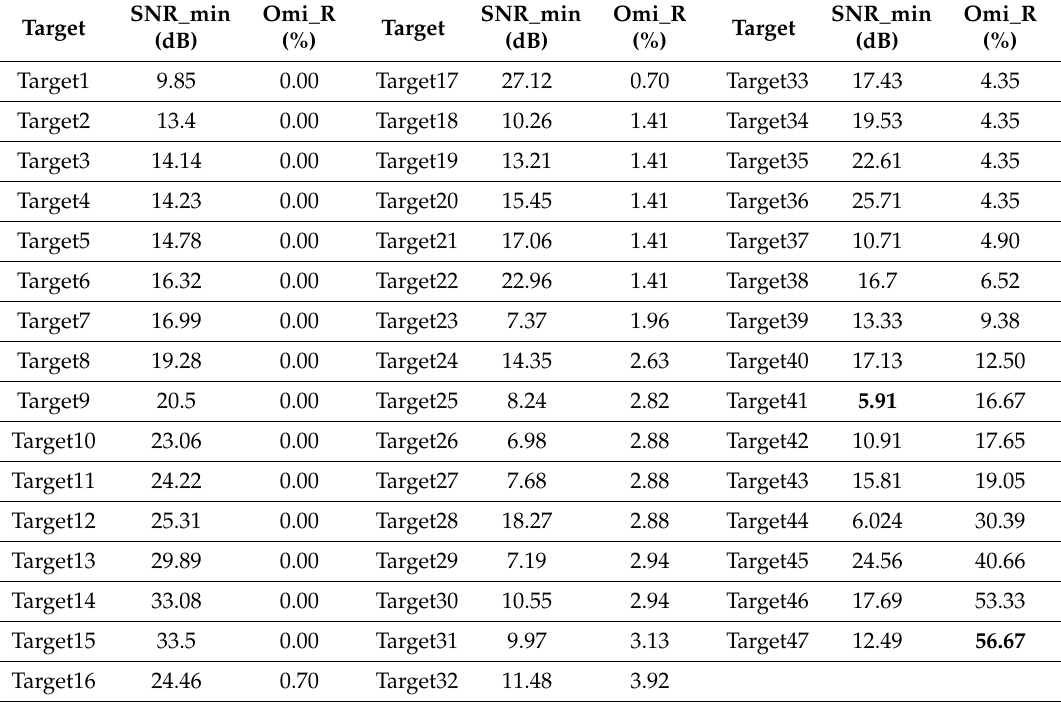
Table 3. Minimum SNR and missed detection accuracy of detected